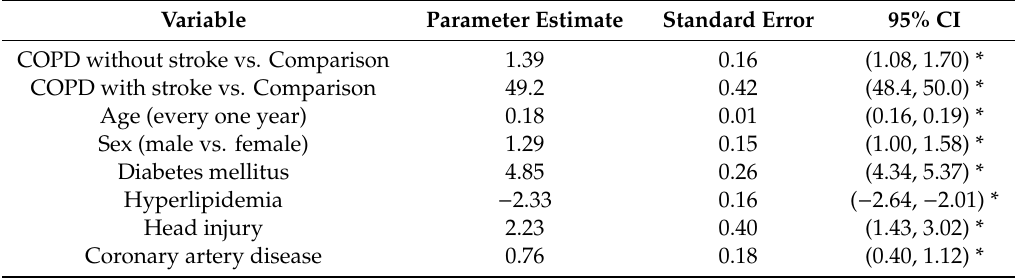
Table 4. Stepwise regression analysis of the average number of hospitalization days per year (all-cause admission). Variable COPD without stroke vs. Comparison COPD with stroke vs.